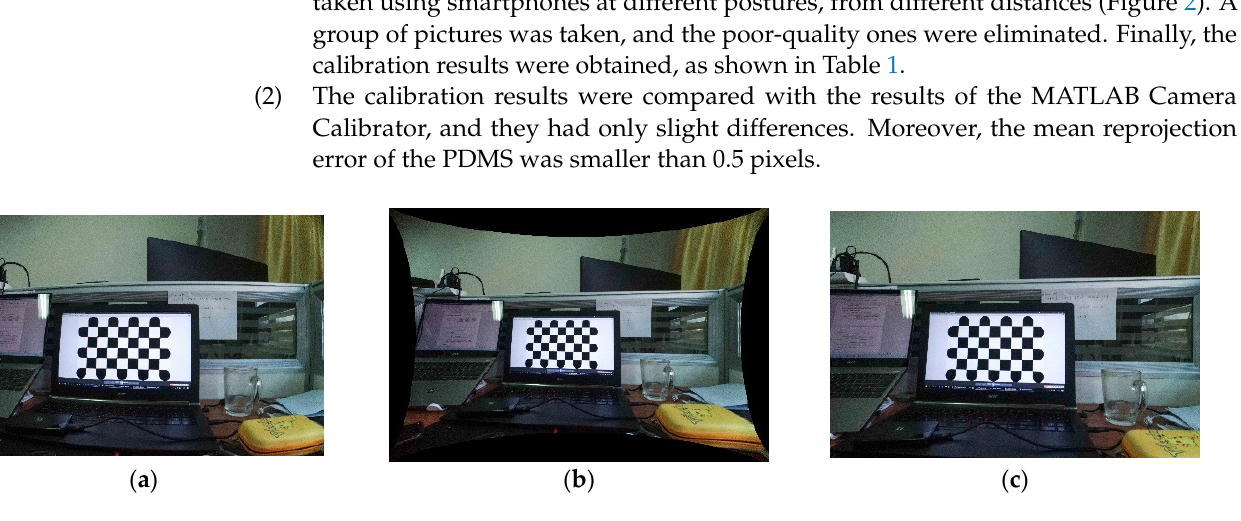
Figure 2. Distortion correction process, showing the ( a ) distorted image, ( b ) image after distortion correction, and ( c ) cut corrected image.